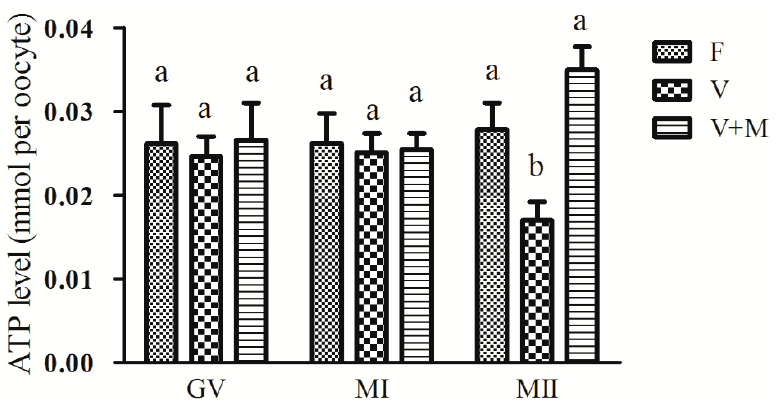
Figure 4. E ff ects of melatonin (MT) on ATP content in vitrified-warmed GV-stage mouse oocytes during in vitro maturation. ATP contents were evaluated in vitrified-warmed mouse oocytes at di ff erent stages of development (GV, MI, and MII). Fresh control (F), vitrification (V), and vitrification + MT (V + M). Total number of GV oocytes used in this assay n = 335 (F: n = 103; V: n = 121; V + M: n = 111). Data are presented as mean ± SEM of three independent experiments. Di ff erent superscripts (a and b) indicate significant di ff erence ( p < 0.05) between groups at the same time point (at corresponding developmental stage).